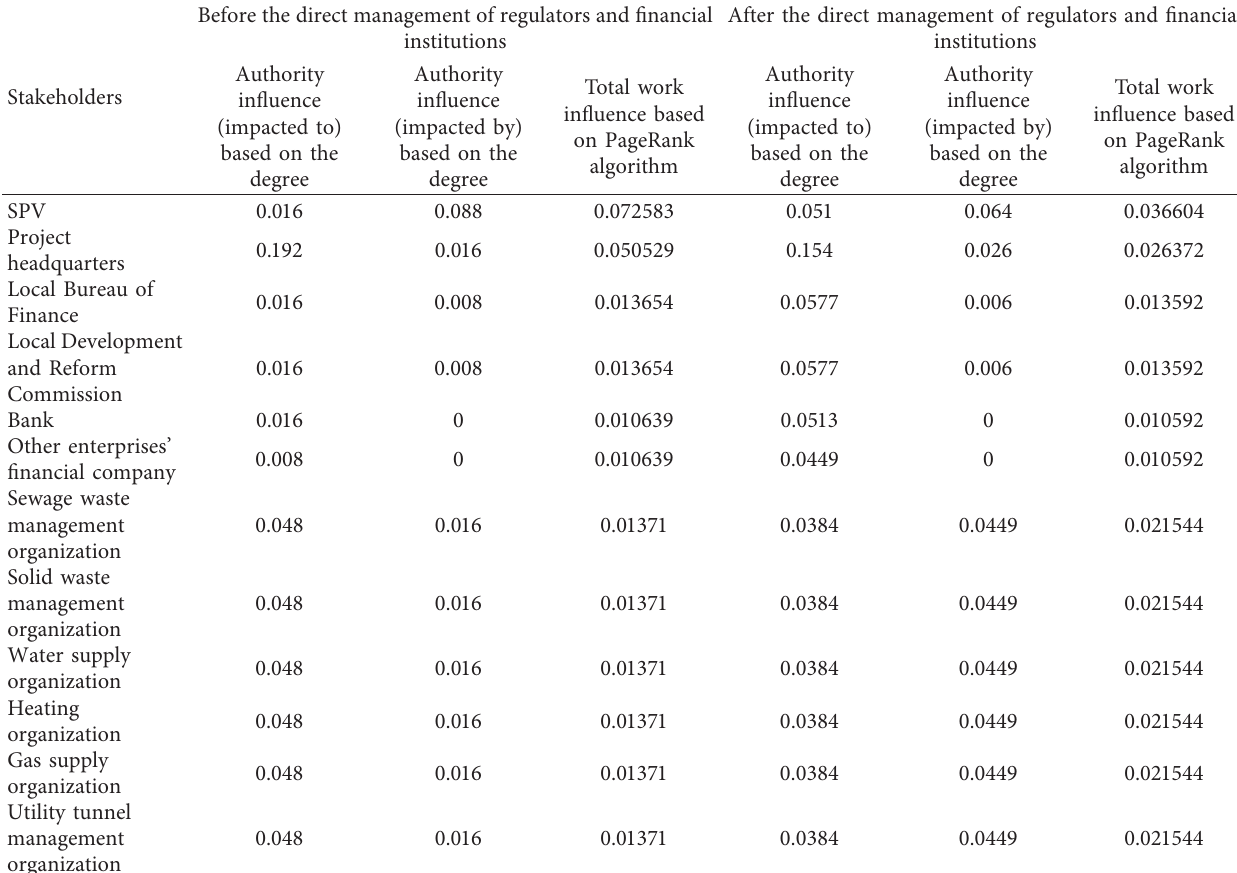
Table 4: Comparison of the stakeholders’ influence before and after the direct management of regulators and financial institutions. Before the direct management of regulators and Stakeholders